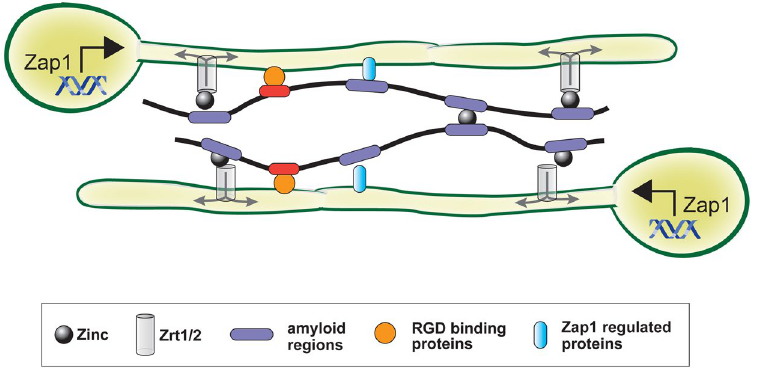
Figure 8. Model of Sap6 mediated cell-cell aggregation. C . albicans Sap6 contains amyloid regions (purple ovals) that function in autoaggregation by binding with hyphal surface Zap1 regulated proteins (blue ovals) and by binding with other amyloid regions mediated by zinc. Amyloid binding of zinc may also function to transfer zinc to fungal zinc transporters Zrt1/2 for uptake under zinc limiting environments. Sap6 RGD binding domains (red ovals) also binds cell surface RGD adhesins (gold circles) that contribute to